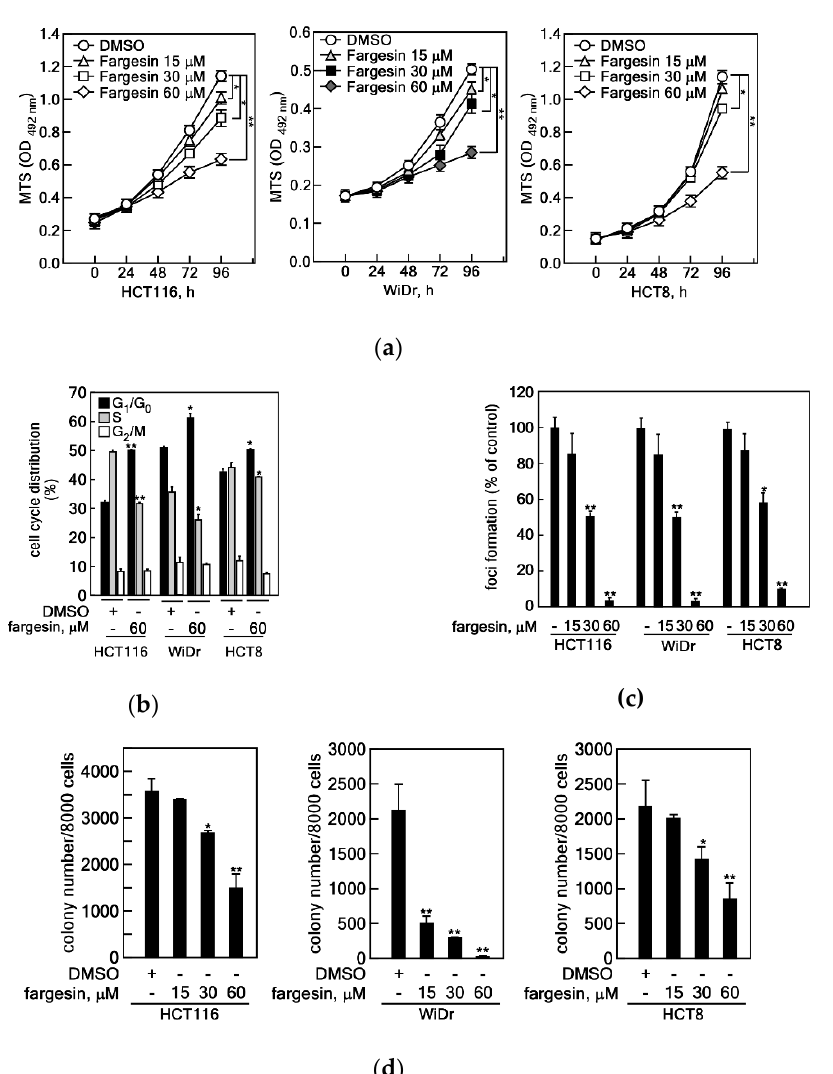
Figure 2. Effects of fargesin on the cell proliferation and colony growth of colon cancer cells. ( a ) Fargesin inhibits cell proliferation of colon cancer cells. HCT116 (2 × 10 3 ), WiDr (1 × 10 3 ), and HCT8 (1 × 10 3 ) colon cancer cells were seeded into 96-well plates, cultured overnight, and treated with indicated doses of fargesin. Cell proliferation inhibition was measured by MTS assay with 24-h intervals up to 96 h. ( b ) Fargesin induces the G 1 phase of and suppresses the S phase of the cell cycle population in colon cancer cells. HCT116 (2 × 10 5 ), WiDr (2 × 10 5 ), and HCT8 (2 × 10 5 ) colon cancer cells were seeded into 60-mm cell culture dishes, cultured overnight, and treated with fargesin (60 µ M) for 24 h. The cell cycle phase population was measured by flow cytometry. ( c ) The effects of fargesin on the foci formation of colon cancer cells. HCT8 (1 × 10 3 ), WiDr (1 × 10 3 ), and HCT116 (1 × 10 3 ) cells were seeded into 6-well cell culture plates, cultured overnight, and treated with indicated doses of fargesin. The cells were cultured for 7–10 days and foci formation was visualized by crystal violet staining/destaining. ( d ) The effects of fargesin on the colony growth of colon cancer cells. HCT116 (8 × 10 3 ), WiDr (8 × 10 3 ), and HCT8 (8 × 10 3 ) colon cancer cells were mixed with 0.32% top agar supplemented with indicated doses of fargesin and poured onto bottom agar, which contained indicated doses of fargesin. After the top agar hardened, the cells were cultured for 10–14 days at 37 ◦ C, in a 5% CO 2 incubator. The colonies were observed under an ECLIPSE Ti inverted microscope and scored using the NIS-Elements AR (V. 4.0) computer program. ( a – d ) Data: a triplicate experiment; values: ± SEM; significance: * p < 0.05, ** p < 0.01 vs. non-treated control by Student’s t